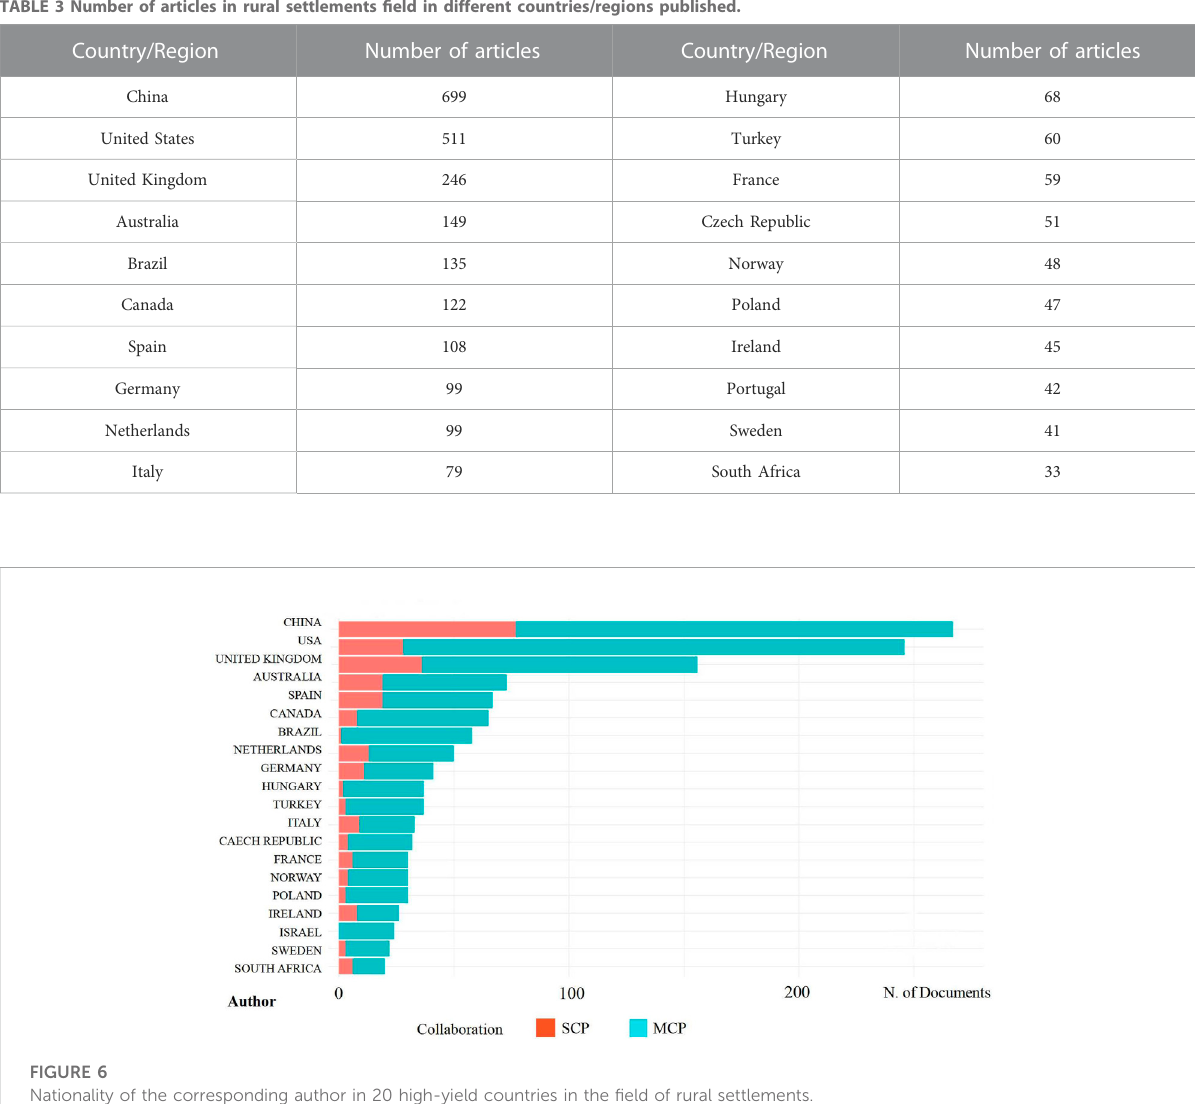
Nationality of the corresponding author in 20 high-yield countries in the fi eld of rural